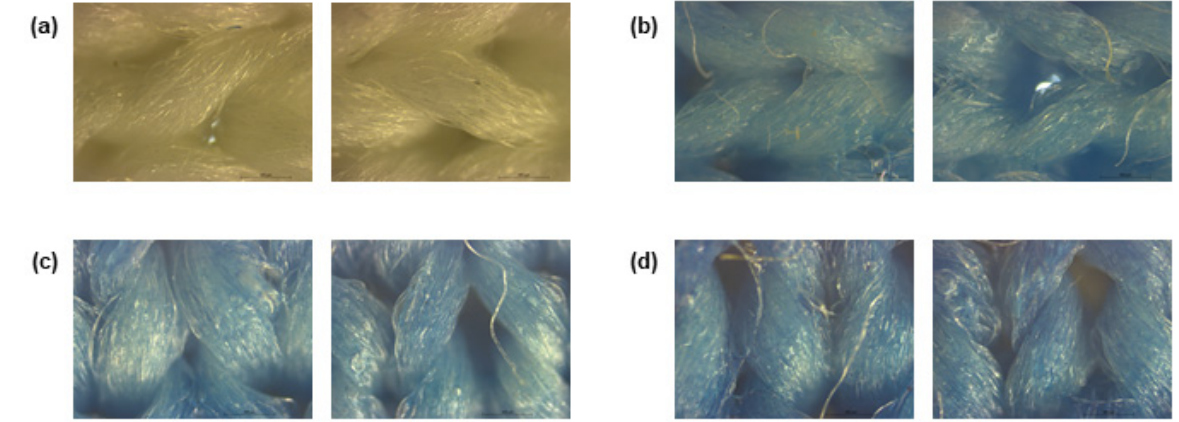
Figure 1. Polyester fibres observed under a microscope at a total magnification of 50, ( a ) before coating and after coating with Prussian blue with a concentration of ( b ) 0.5 g/L, ( c ) 1 g/L and ( d ) 2 g/L.